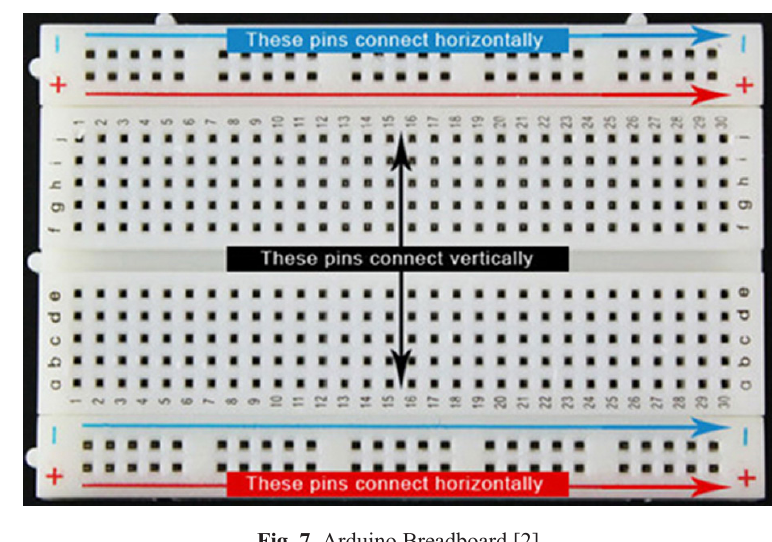
Fig. 7. Arduino Breadboard